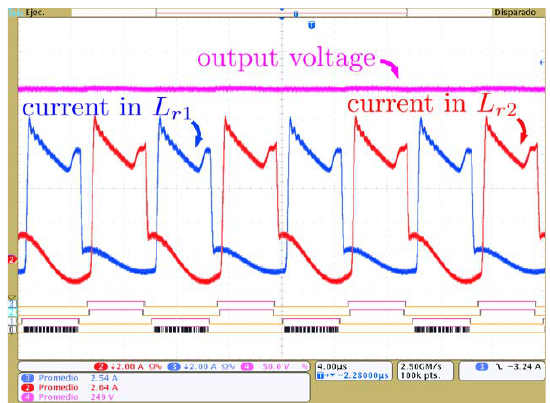
Figure 14. Measurement of the resonant inductor currents in both interleaving parallel connected EACF converters.